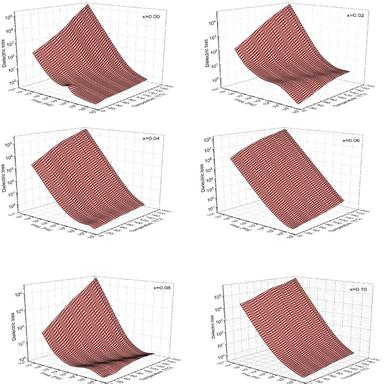
Plots of dielectric loss of NCZFe2-4xSn3xO4 NSFs as functions of frequency and temperature.